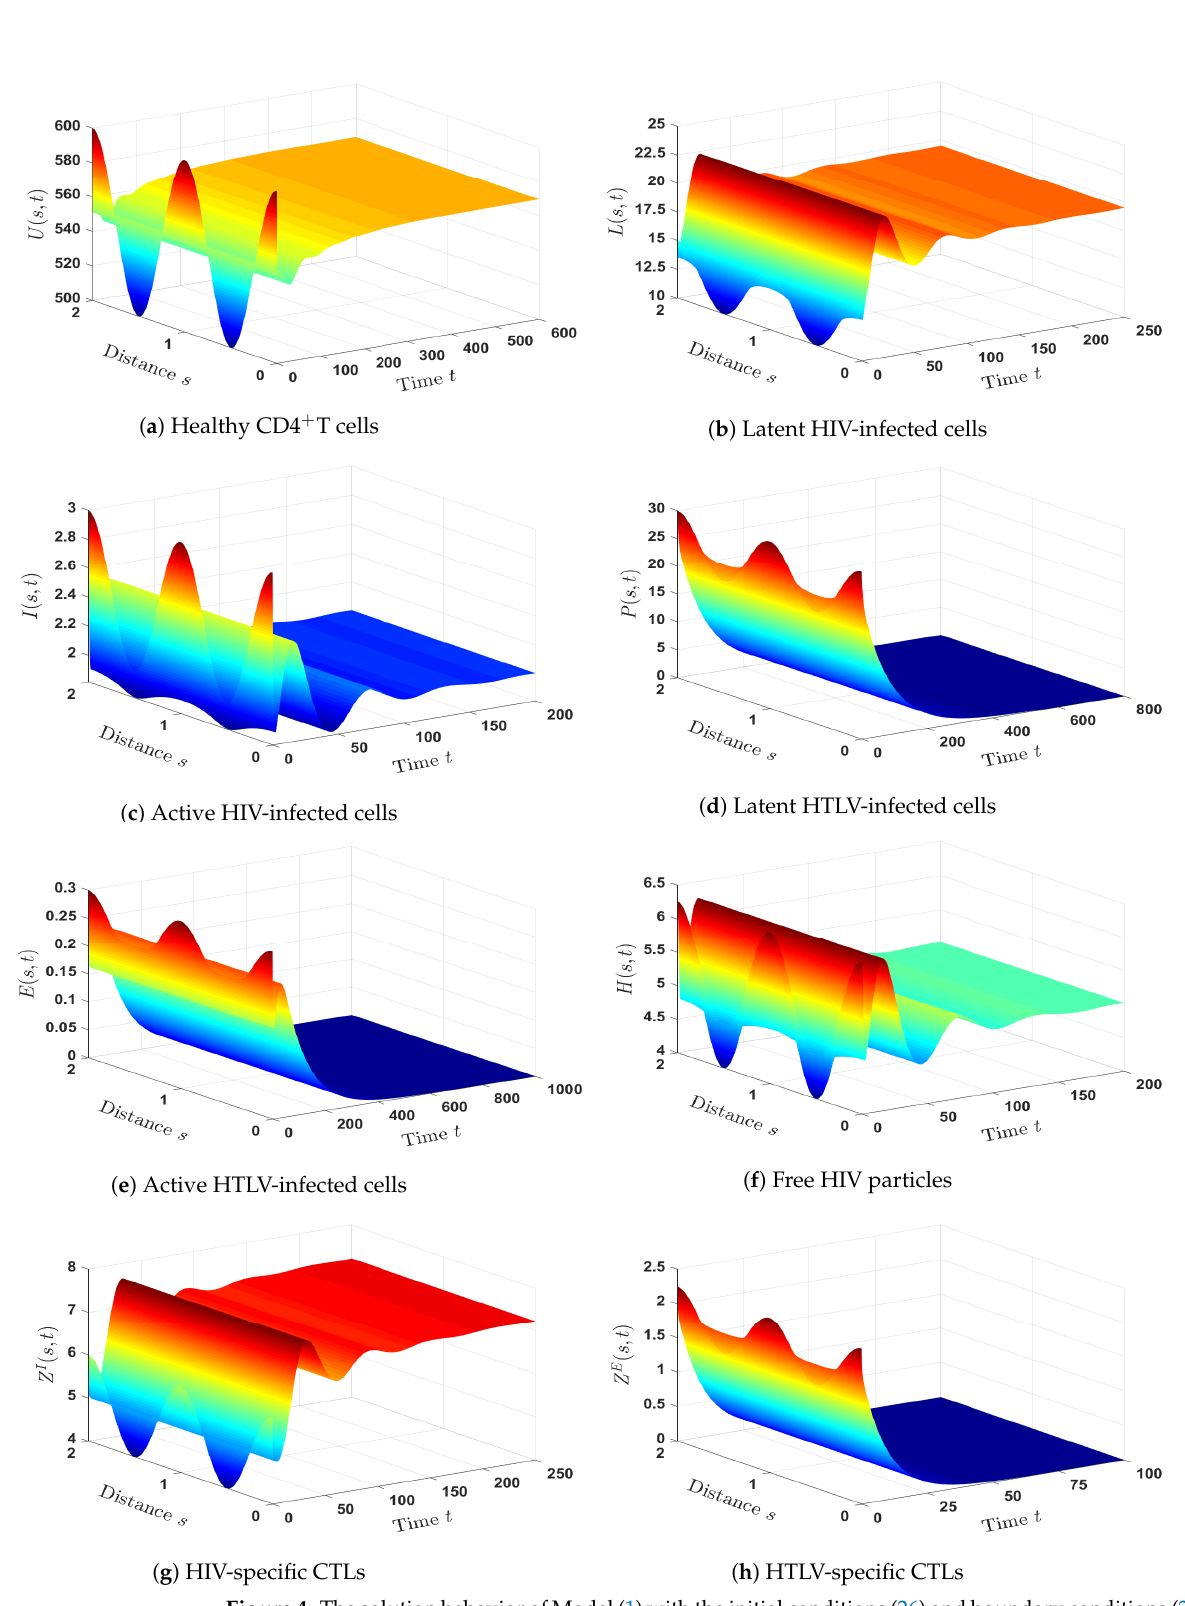
Figure 4. The solution behavior of Model (1) with the initial conditions (26) and boundary conditions (27). Taking ω 1 = 0.001, ω 2 = 0.0001, ω 3 = 0.0003, ω 4 = 0.001, υ 1 = 0.05, υ 2 = 0.005, we have R 3 = 3.91 > 1, R = 0.22 < 1, and the equilibrium ˇ S = ( 569.59,19.56,2,0,0,5,7.28,0 ) is asymptotically 5 3